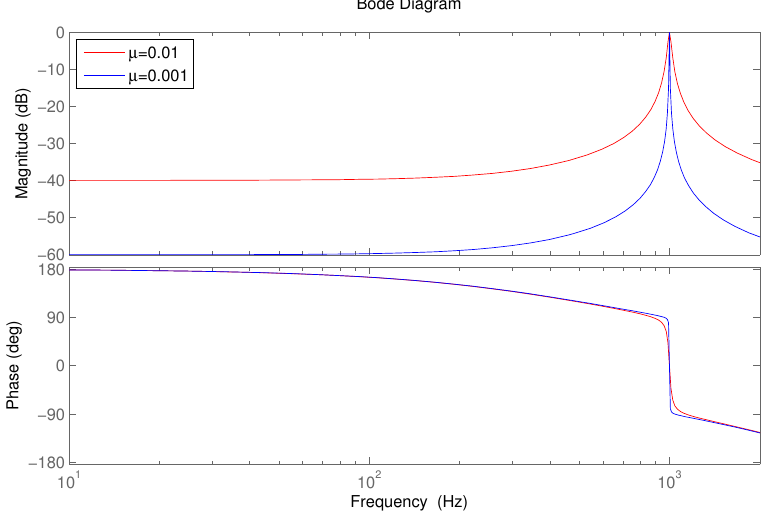
Figure 10. The magnitude-phase characteristic of H ( z ) : C = 1, µ = 0.01 (red line); C = 1, µ = 0.001 (blue line).